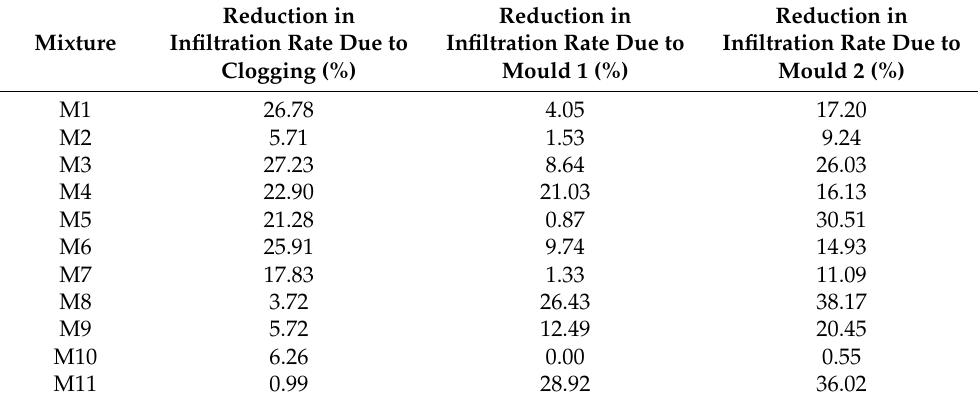
Table 5. Reduction in infiltration rates due to clogging and mould